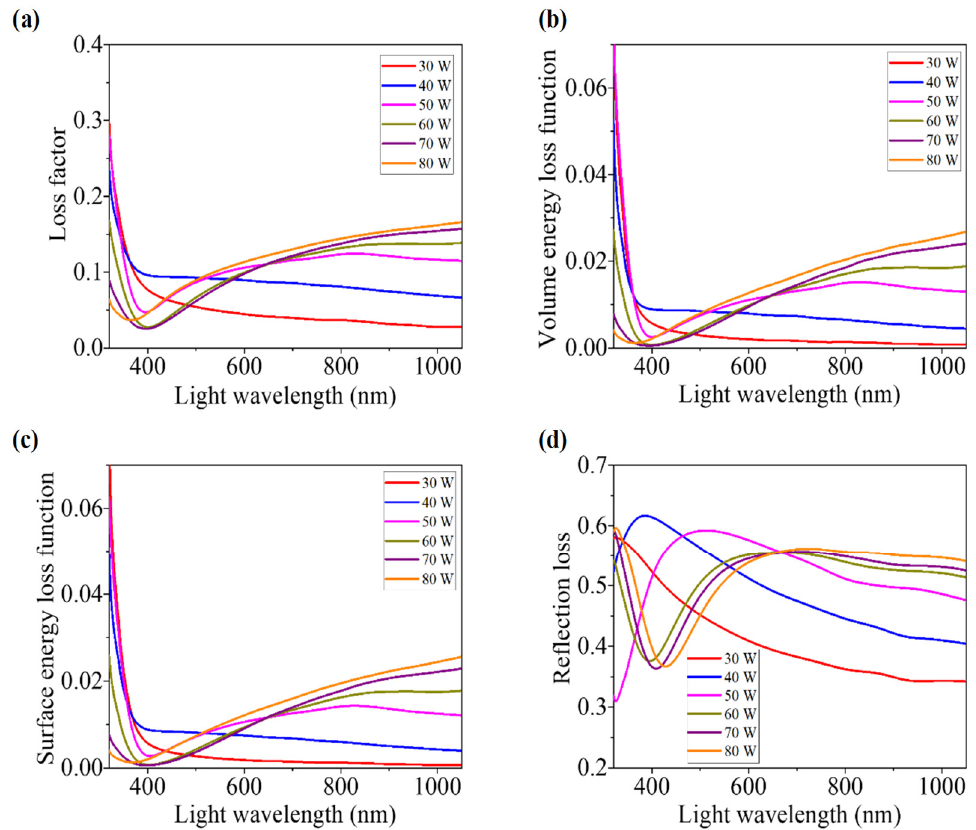
Figure 8. ( a ) Loss factor, ( b ) volume energy loss function, ( c ) surface energy loss function, and ( d ) reflection loss versus wavelengths of light for RF sputtering power ‐ varied WO x films.